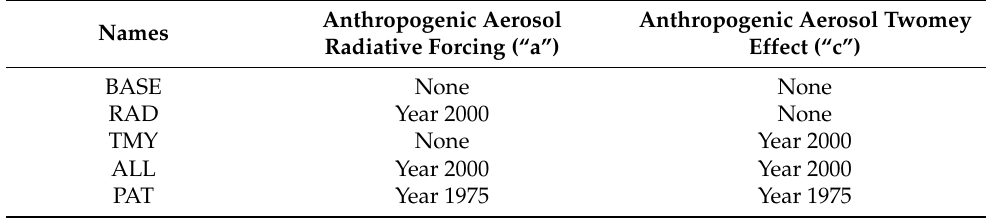
Table 3. List of